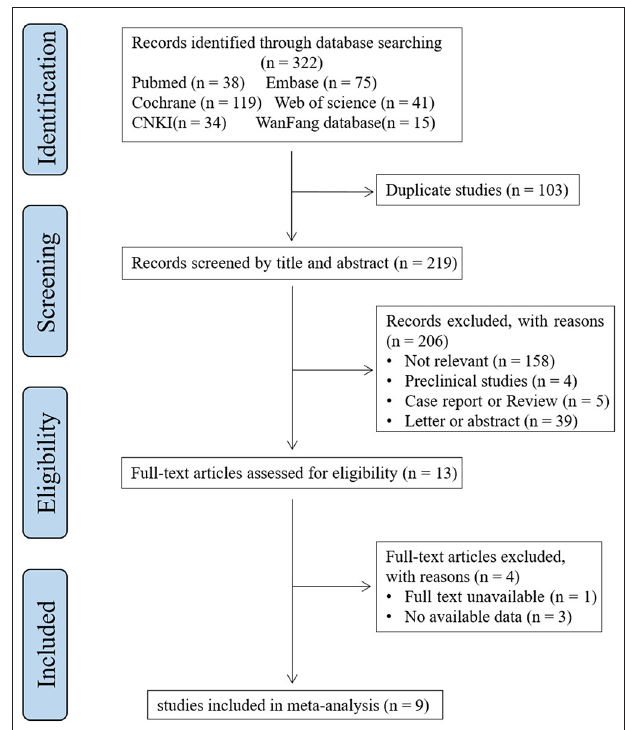
FIGURE 1 | PRISMA flowchart for the literature